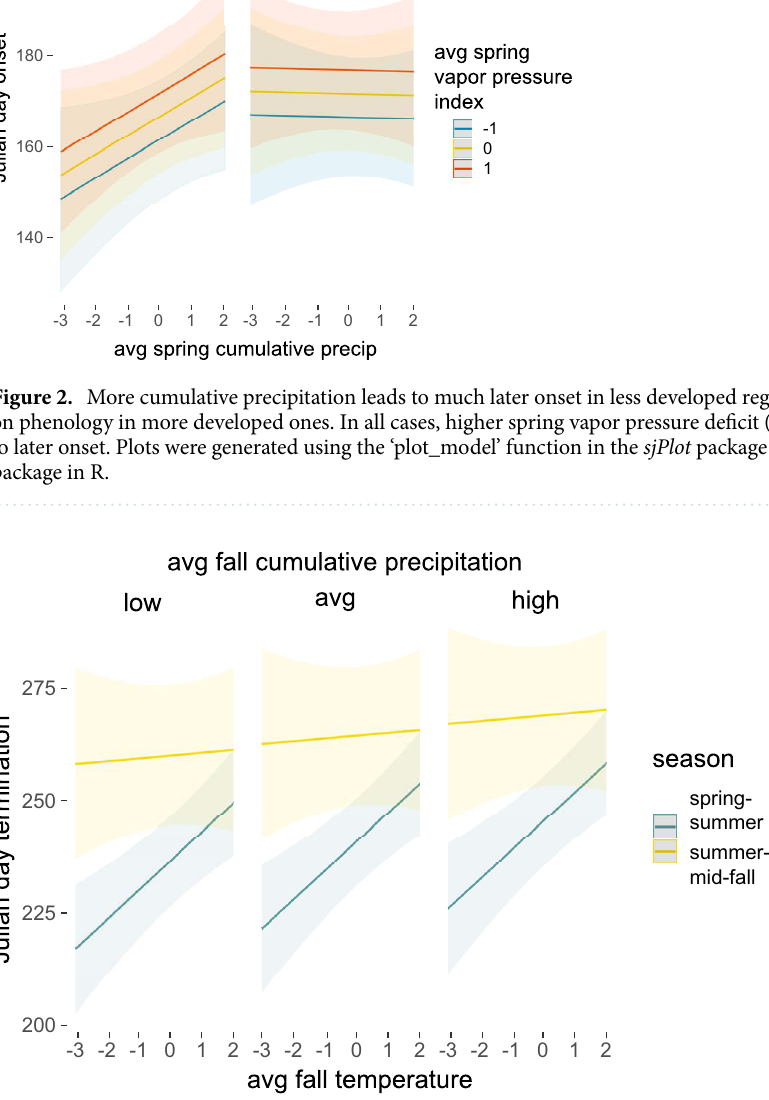
Figure 3. Increasing average late Summer-early Fall temperatures lead to much later termination in Spring– Summer flying species, but this impact is much weaker for Summer-mid-Fall flying ones. More precipitation also leads to later termination but the strength of this predictor is not conditioned on flight timing. Plots were generated using the ‘plot_model’ function in the sjPlot package and functions in ggplot2 package in